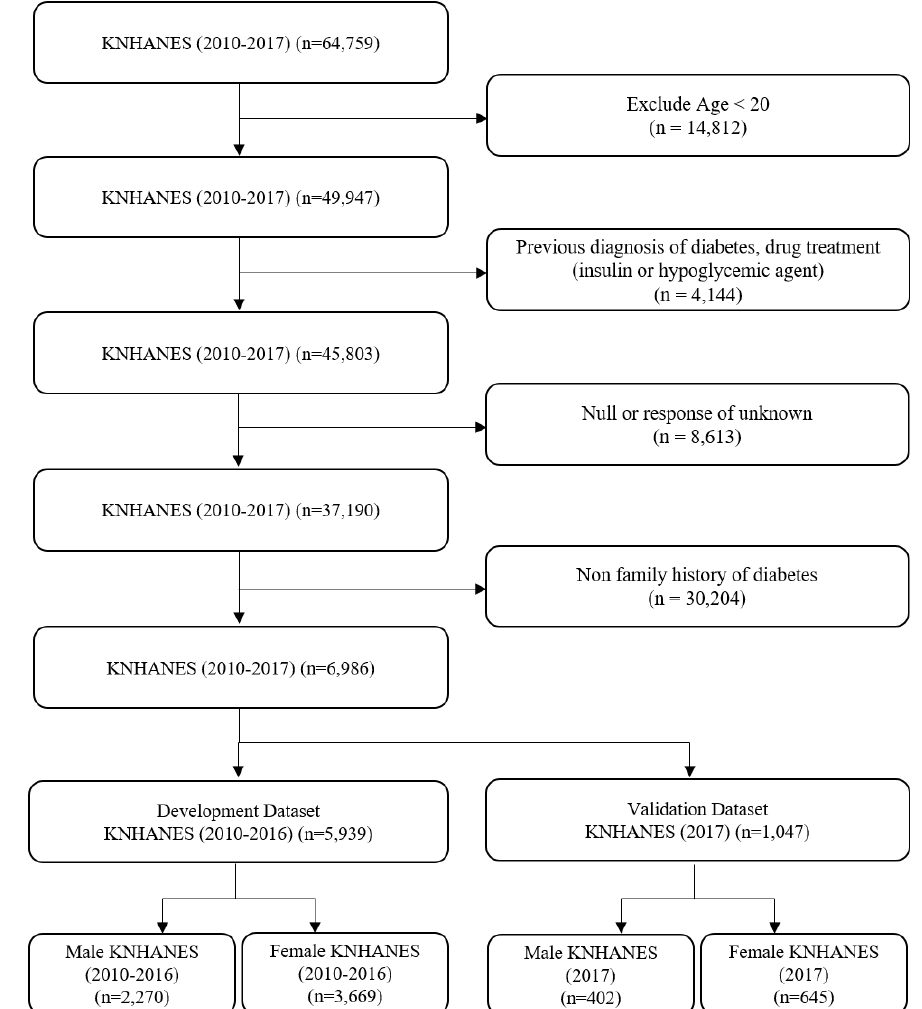
Figure 2. Flow chart for selecting the study population.